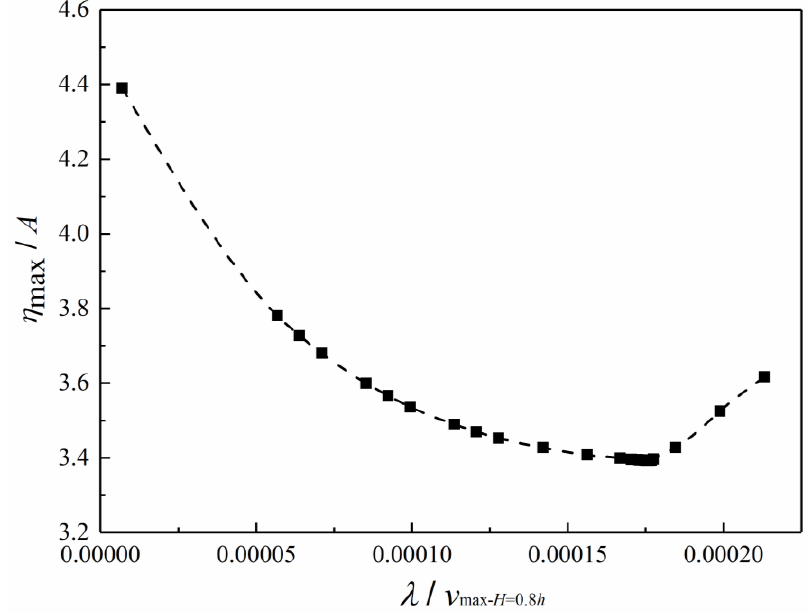
Figure 16. The maximum elevation of free surface at y = 0 of sloshing under different baffle permeability coefficients (the unit of permeability coefficient λ is m/s).